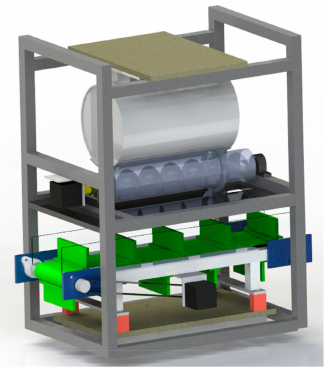
Figure 24. 3D model of the new scheme.